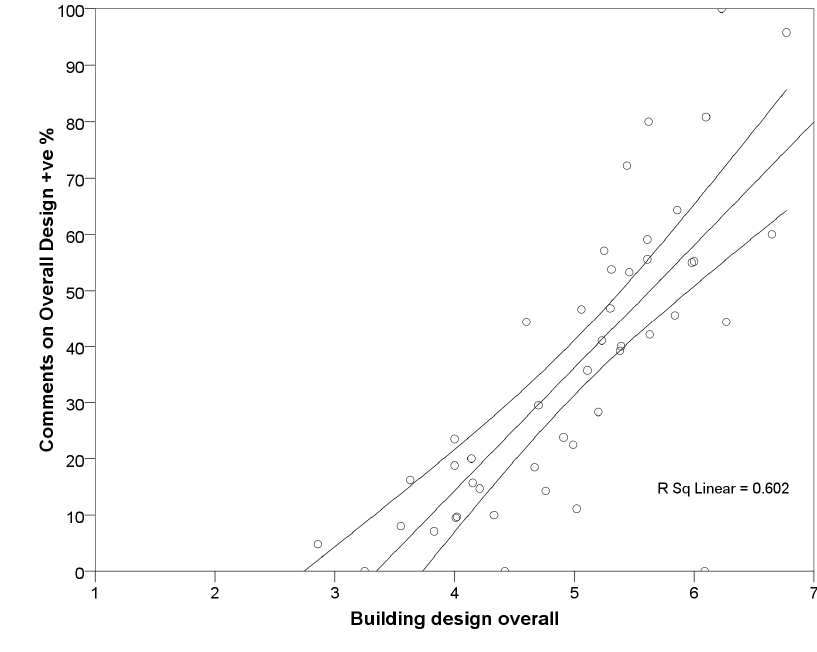
Figure 1. Graph of percentage of positive comments vs average scores for Overall Design.